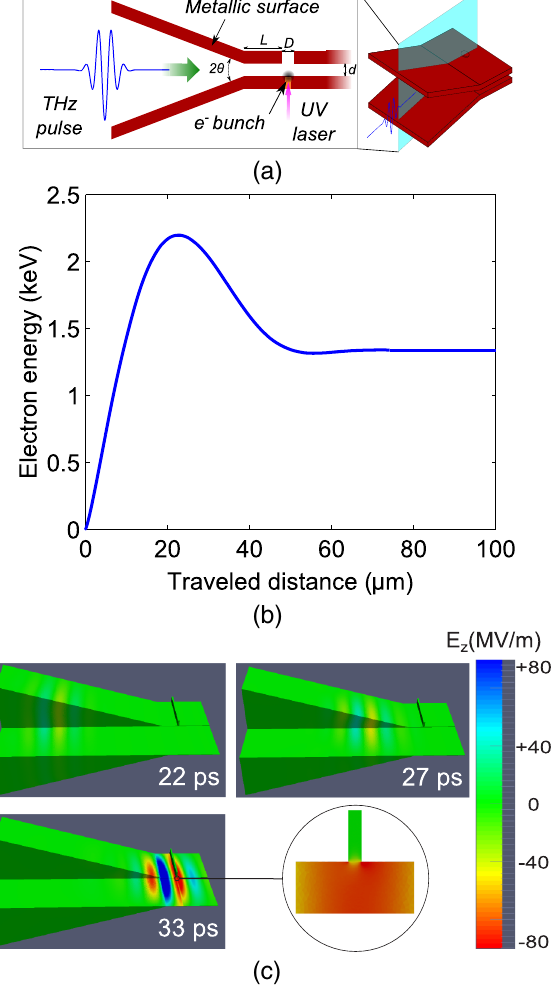
FIG. 2. (a) Schematic illustration of the planar single cycle THz gun, (b) Energy of an electron released at the instant with E 50 MV = m versus the traveled distance, (c) Snapshots of the accelerating field ( E ) profile over two half-space cuts of the gun z at t 1 ¼ 22 ps, t 2 ¼ 27 ps, and t 3 ¼ 33 ps.